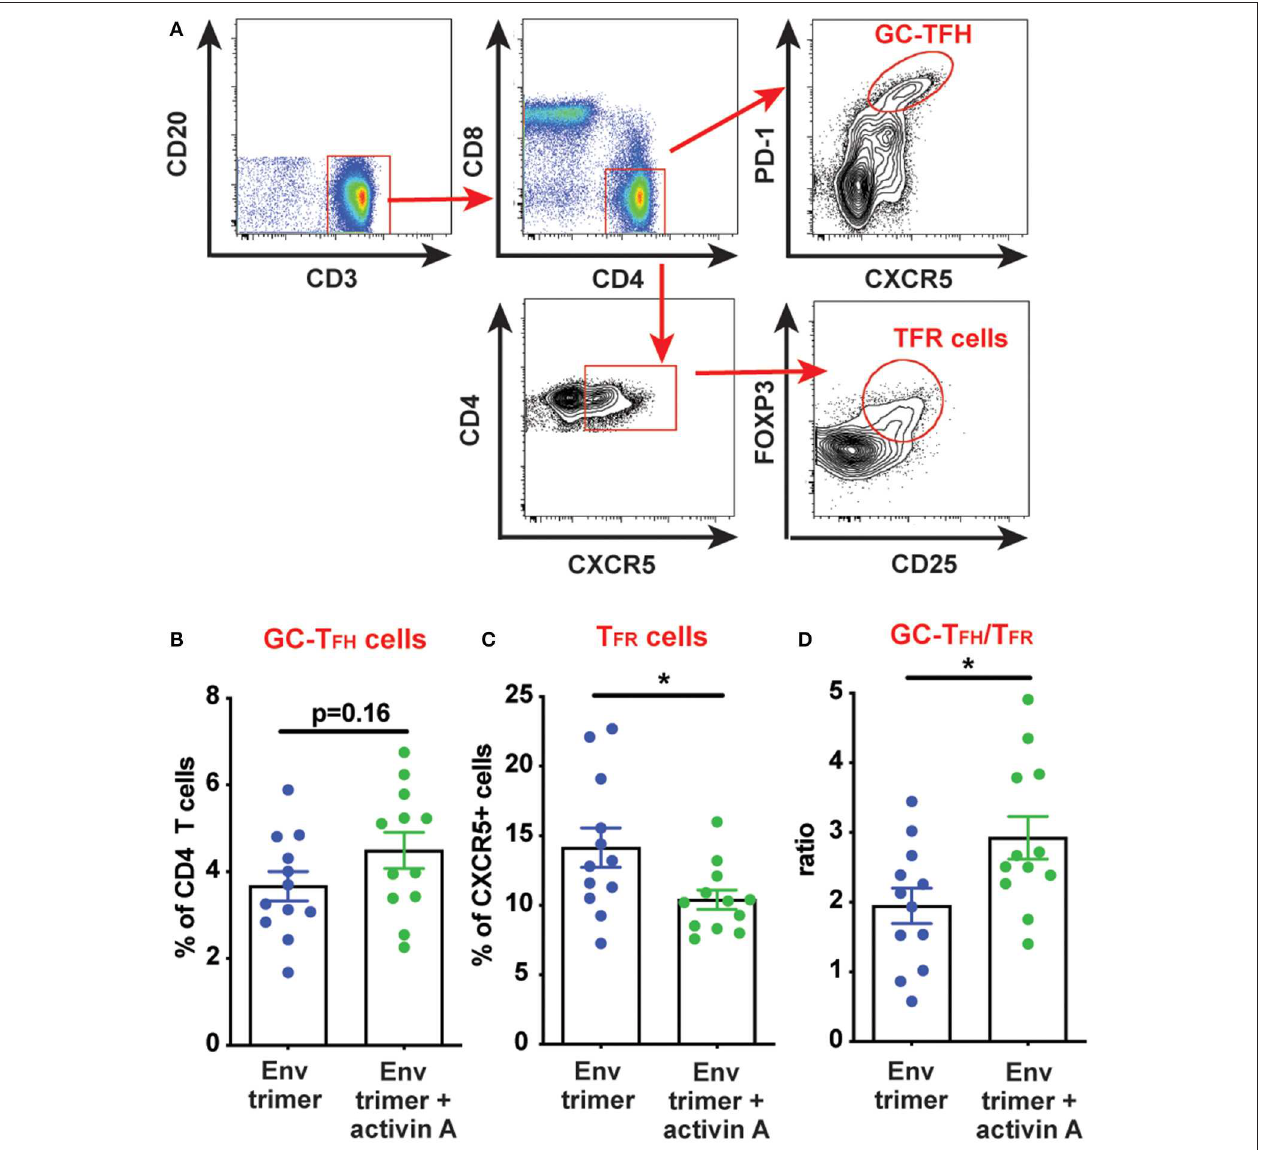
FIGURE 4 | Modulation of T FH and T FR cells by activin A. T cell populations were analyzed by flow cytometry in iliac lymph nodes at week 14. (A) A representative gating strategy is depicted for GC-T FH cells and T FR cells. Initial plot is gated on CD20 − live cells. (B,C) Graphs show quantitation of: (B) GC-T FH cell frequency as percentage of CD4 + CD8 − CD3 + CD20 − live cells; and (C) T FR cell frequency as percentage of CXCR5 + CD4 + CD8 − CD3 + CD20 − live cells. (D) Ratio of GC-T FH cells to T FR cells within CXCR5 + CD4T cells at the necropsy time point. In (B–D) each symbol represents a pool of “right” or “left” iliac LNs from an independent animal. Bars show mean + s.e.m. * p <